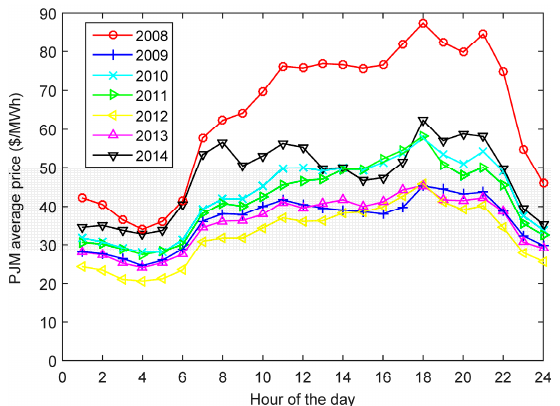
Figure 3. Hourly-based average prices of electricity in the real-time market (RTM), encompassing 7395 PJM nodes.